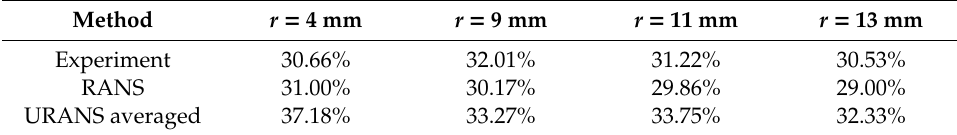
Table 4. Experimental and numerical results of static pressure efficiency.